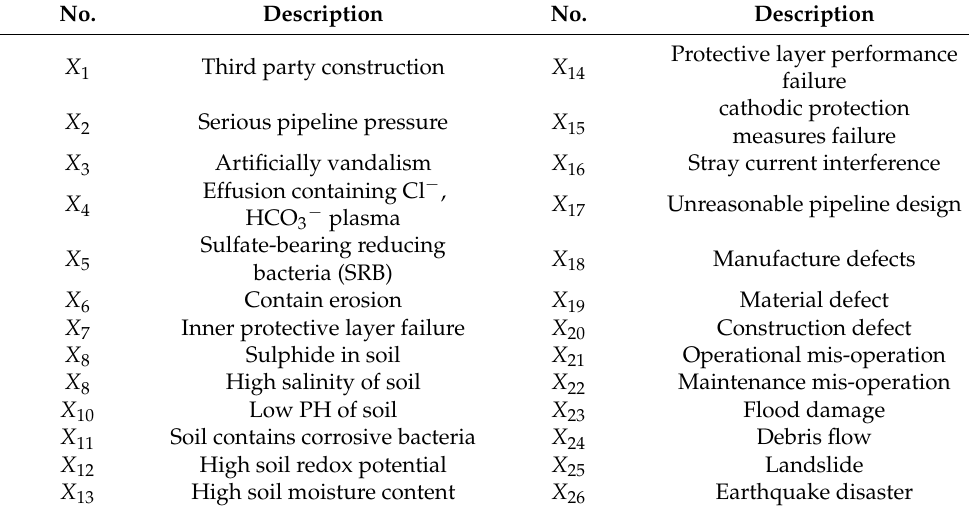
Table 6. The failure factor of pipeline.